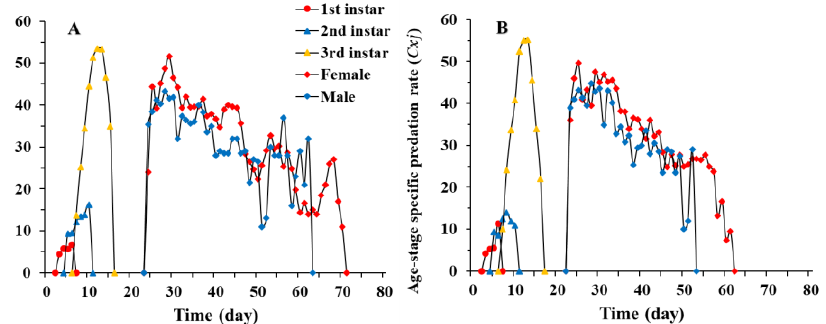
Figure 3. Age-stage specific predation rate ( c xj ) of Chrysopa pallens ever cultured on Megoura japonica ( A ) and Corcyra cephalonica eggs ( B ) under fluctuating temperature conditions in a greenhouse.